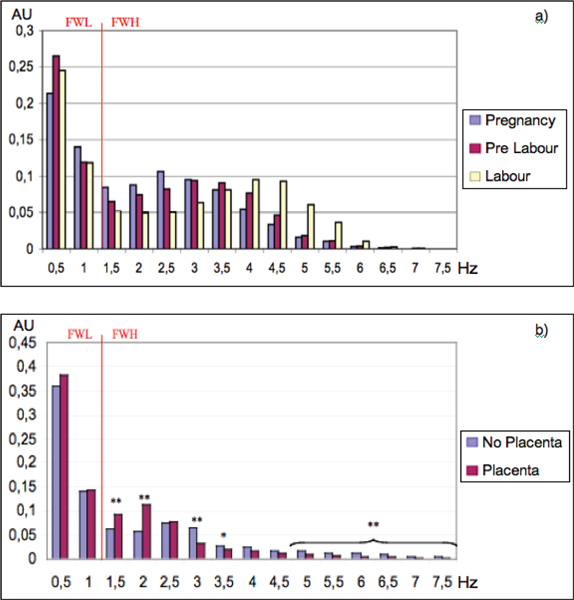
Analysis of term and placental influences on the relative energy spectrum of uterine electrical signals. (a) Relative energy spectrum (RES) computed from pregnant monkey EMGs recorded during the last third of pregnancy and labour. Notice the shift towards higher frequencies as pregnancy progresses. (b) RES computed from pregnant monkey EMG's recorded during pregnancy, with two electrode positions: electrodes away from the site of placenta insertion (No Placenta); electrodes located above the placental insertion (Placenta) (**p < 0.01). AU, arbitrary units.